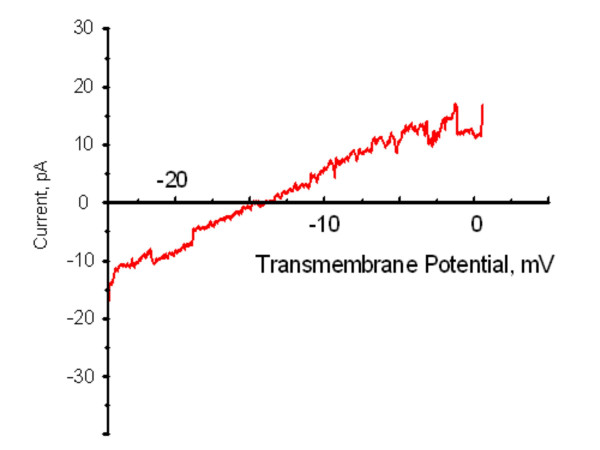
Cation-anion selectivity of L-ArgR channels. The figure shows current elicited by voltage ramps across a lipid bilayer (DOPS:DOPE, 1:1) containing several channels from the Sephacryl S-300 step, in the presence of a 4-fold gradient of NaCl across the membrane (cis and trans chambers contained 100 and 25 mM NaCl respectively). The reversal potential is -14 mV, corresponding to weak cation selectivity (PNa/PCl = 2.2).